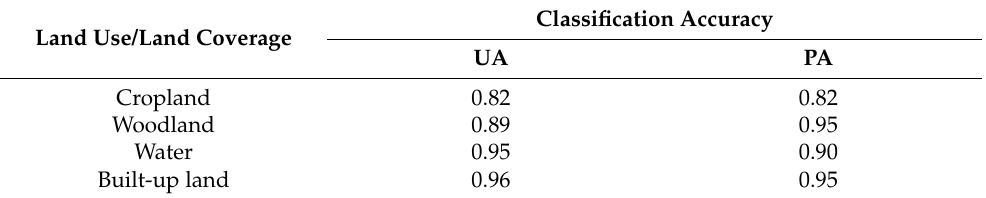
Table 3. Accuracy assessment of different land use/land cover types.